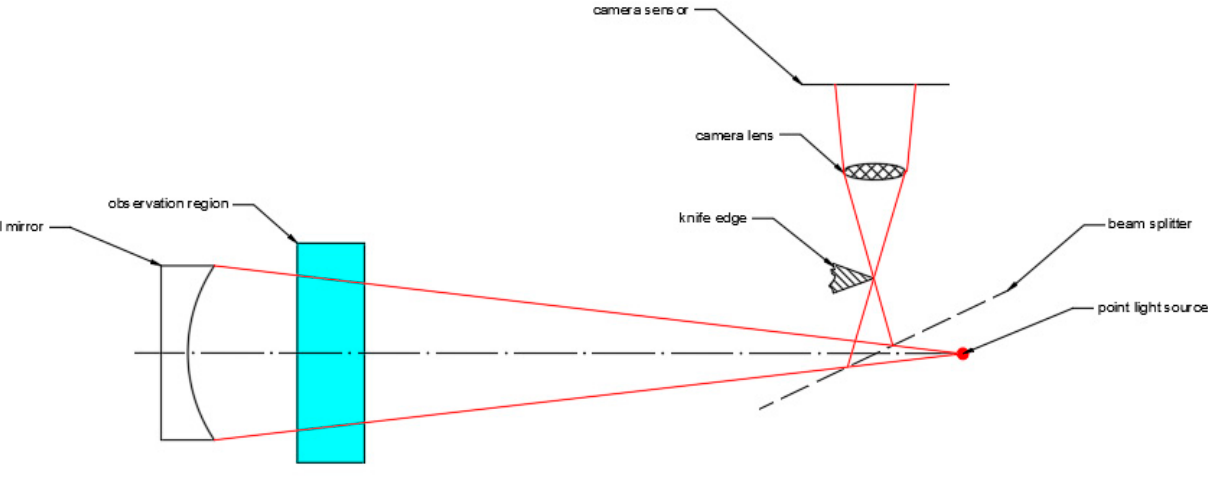
Figure 19. On-axis double-pass Schlieren layout. It is obtained using a spherical mirror as the Schlieren head. The rays reflected by the mirror converge on the focal point and make a spot in the center of the sphere. Positioning the point light source in the center of the sphere, the reflected spot is exactly in the same point, such that all the rays hitting the mirror pass twice through the flow